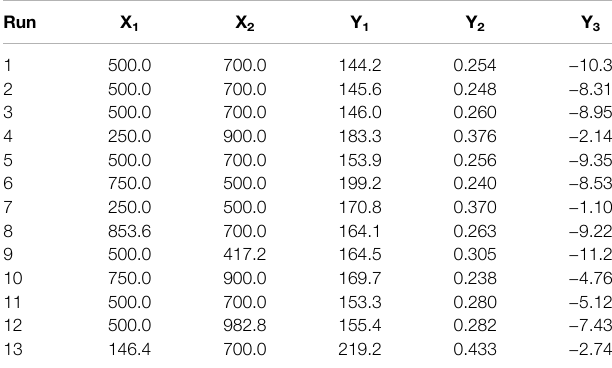
TABLE 1 | Factors (X), levels, and measured variables (Y) corresponding to the fractional factorial or screening design: formulations were synthesized according to the created design. Independent variables considered were: X 1 : the amount of solid lipid (mg); X 2 : amount of surfactant (mg); X 3 : amount of liquid lipid ( μ L); X 4 : time of sonication (min), and; X 5 : sonication power (%). Dependent variables were: Y 1 : particle size (nm); Y 2 : PDI, and; Y 3 : Z-potential (mV).